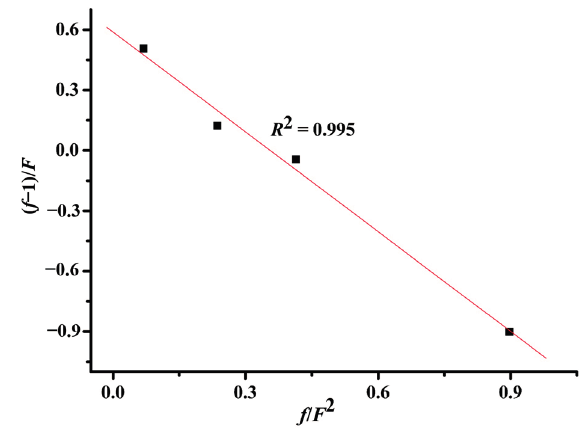
Figure A2. Plot of ( f -1)/ F versus f / F 2 with least-squares regression line for HBM and NMA copolymerization.